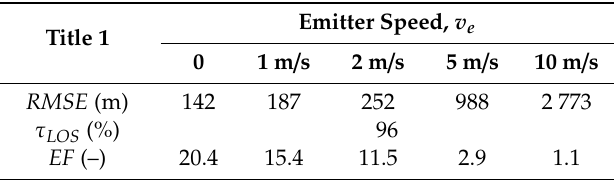
Figure 13. CDFs of the location error versus the emitter speed for a suburban area. Table 3. Effectiveness metrics for the different emitter speeds.